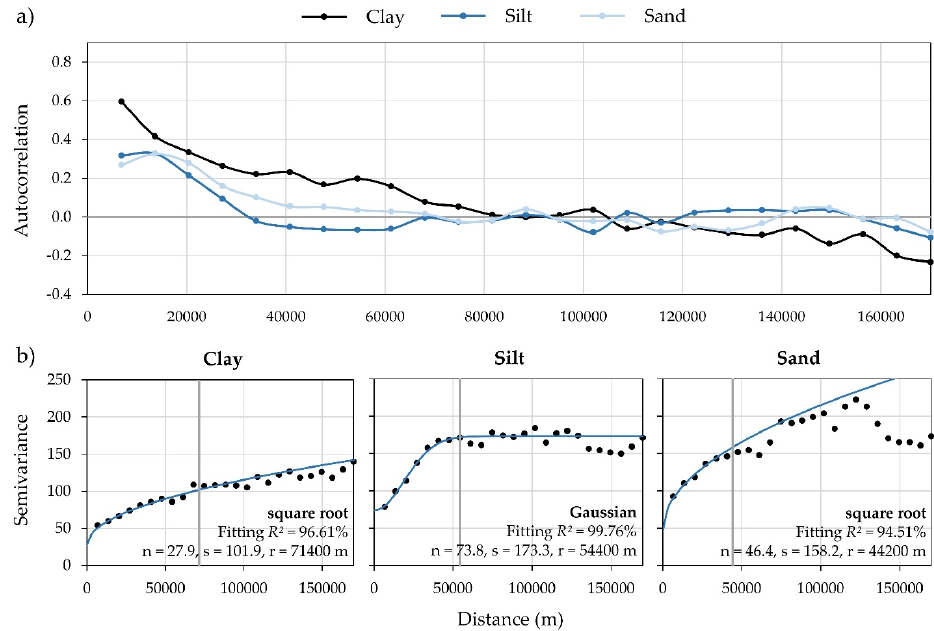
Figure 6. Properties of full sample sets for clay, silt and sand: ( a ) autocorrelogram, ( b ) variograms and OK interpolation parameters (n: nugget, s: sill, r: range).